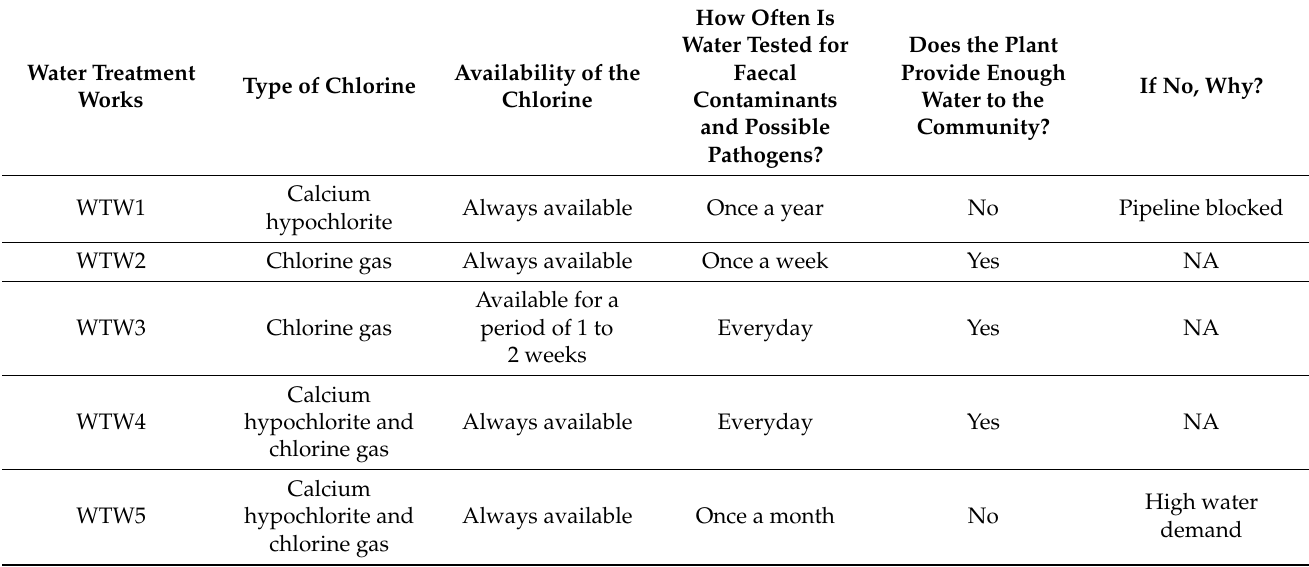
Table 3. Water treatment plant data.